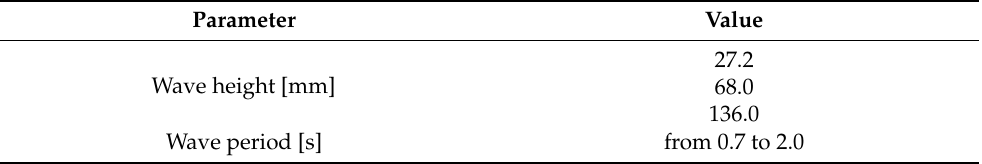
Table 3. Details of the wave conditions